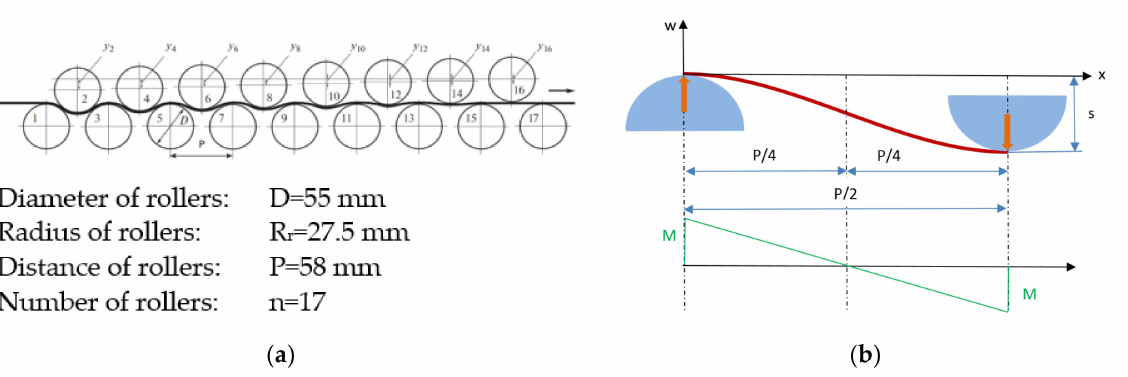
Figure 2. Roller levelling equipment and model parameters; ( a ) roller levelling line; ( b ) dimensions, forces and